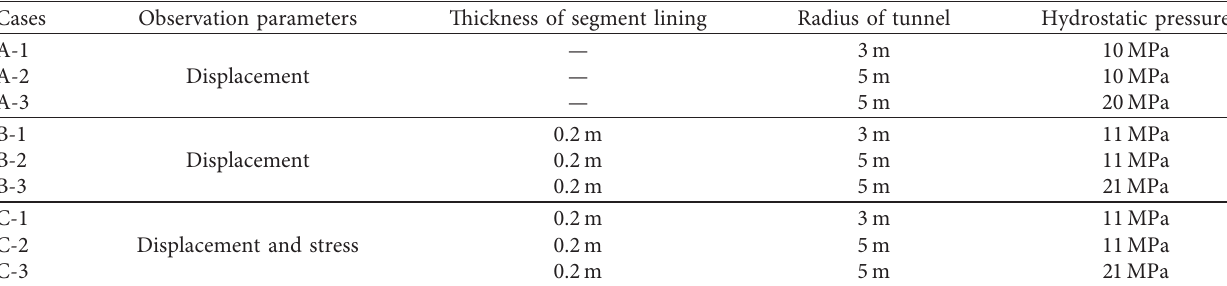
Table 3: Summary of analysis